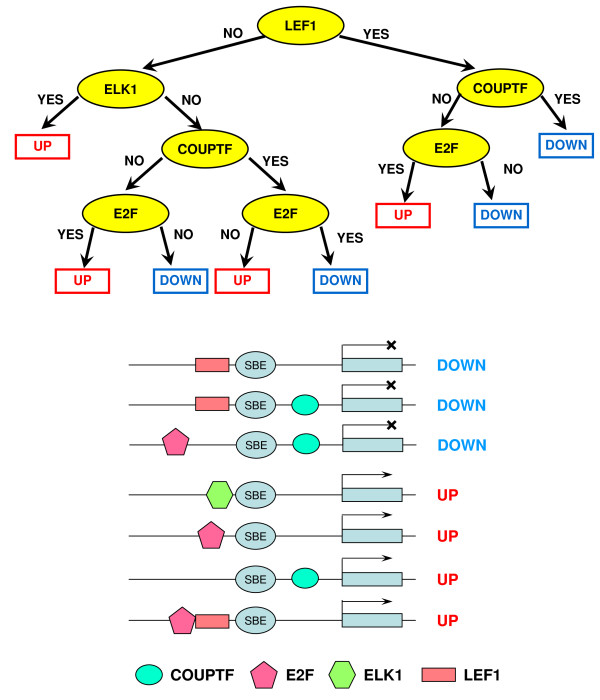
Classification model that discriminates up- and down-regulated TGF-β/SMAD targets and corresponding SMAD co-regulatory modules. Upper panel shows the CART model that discriminates between the TGF-β/SMAD up- and down-regulated targets. Lower panel shows the derived cis-regulatory modules of these target genes identified by the CART model. In the CART trees, "yes" means the TFBS was present and "no" means the TFBS was absent.